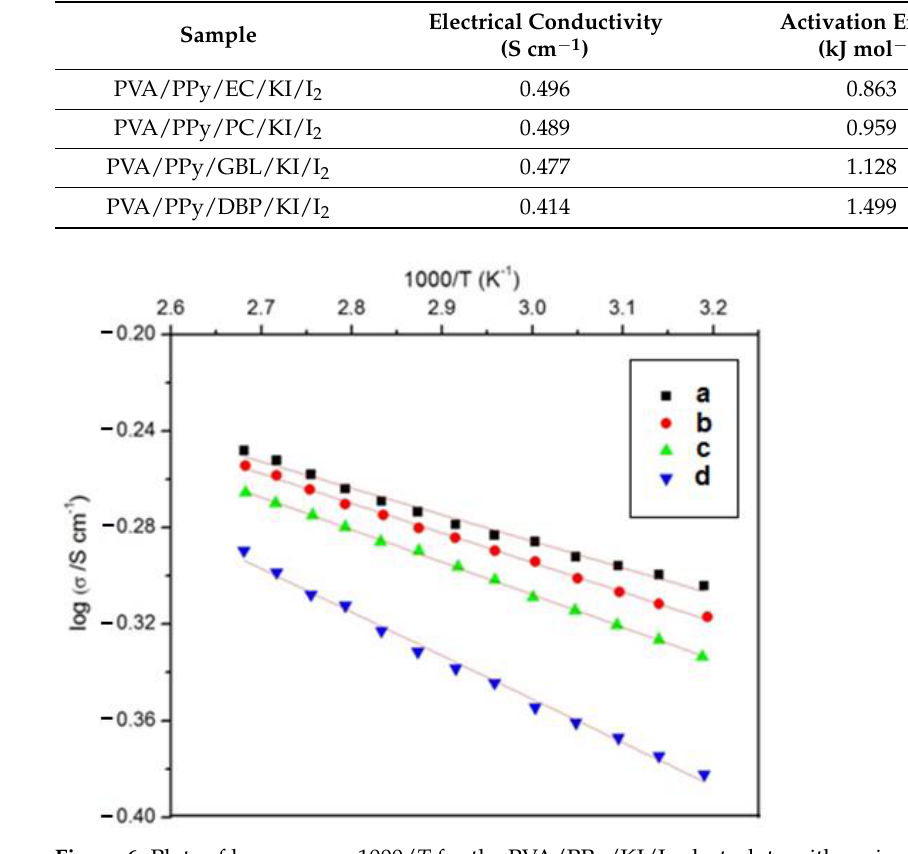
Figure 6. Plots of log σ versus 1000/ T for the PVA/PPy/KI/I 2 electrolyte with various plasticizers (in wt.%); ( a ) EC, ( b ) PC, ( c ) GBL, and ( d ) DBP.